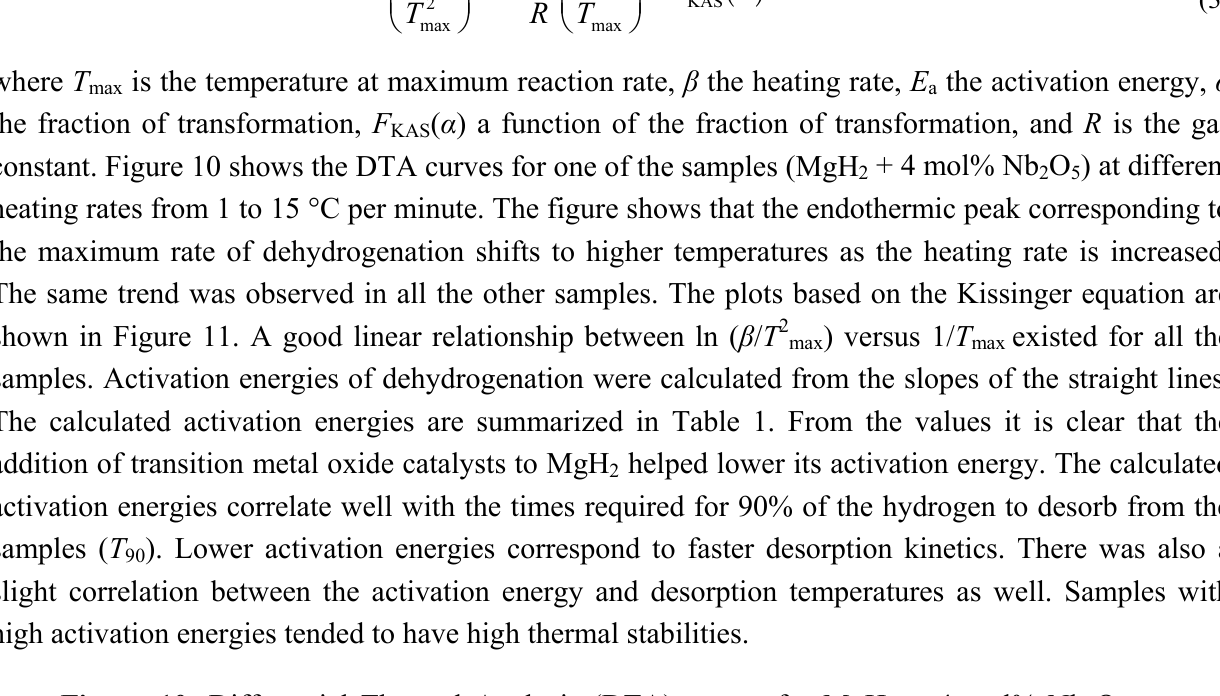
+ 4 mol% Nb O at 2 2 5